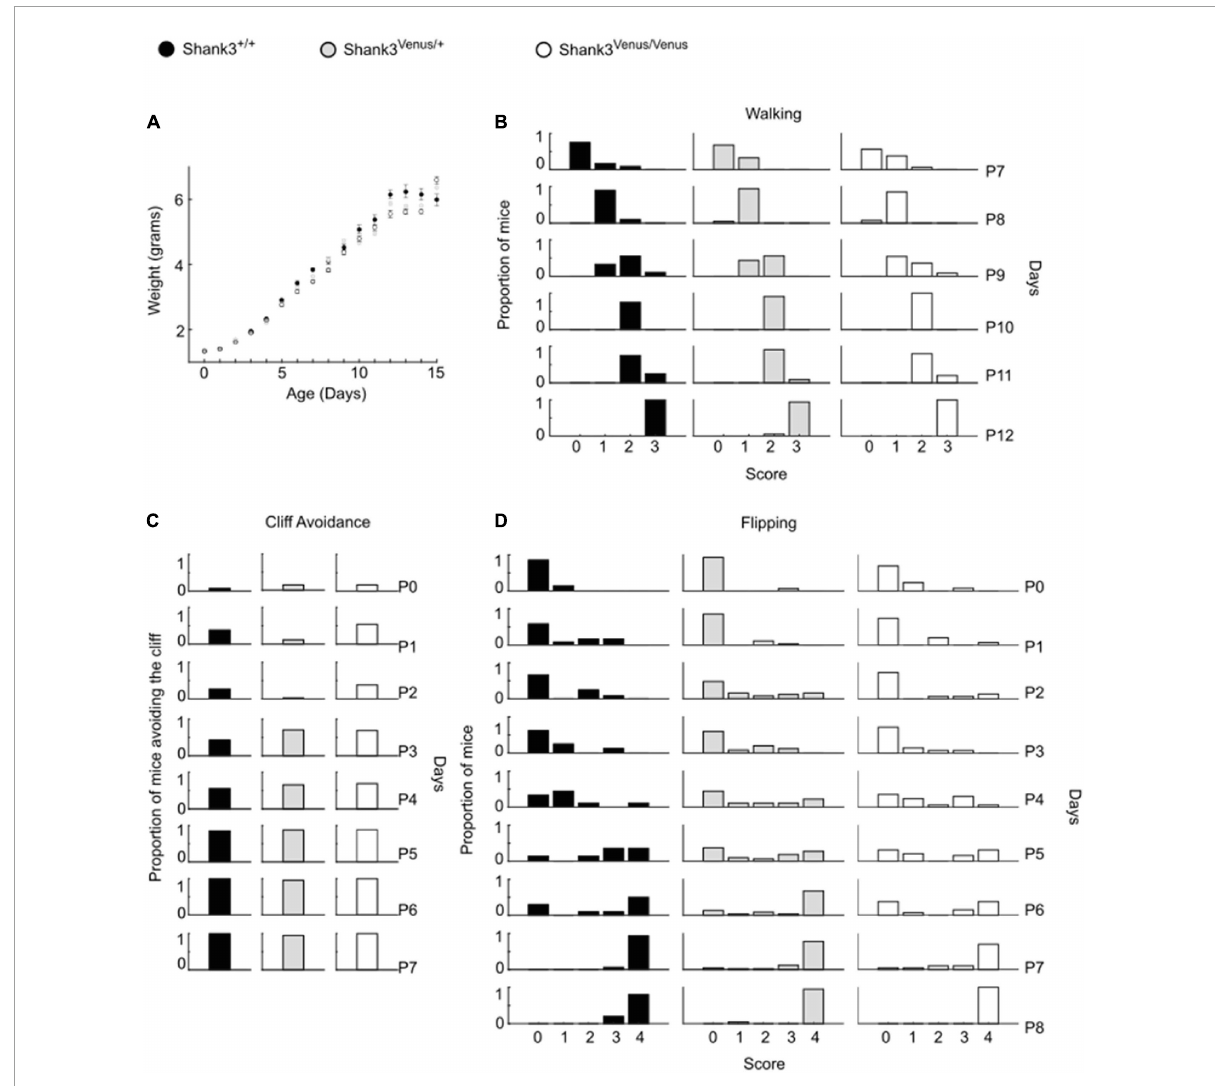
FIGURE2 Psychomotor ability test battery in Shank3 Venus / Venus , Shank3 Venus / + and Shank3 + / + KI pups. All behavioral experiments were performed on at least 18 mice per group. (A) Weight. Pups were weighed from birth to P15. Data are mean ± SEM. (B) Walking. Mice were scored for walking from P7 to P12. Data are proportion of mice reaching the different score through days. GLM, genotype effect: p -value = 0.81, interaction genotype by time: p -value = 0.48. (C) Cliff Avoidance. Proportion of mice avoiding the cliff from birth to P7. GLM, p -value = 1.00. (D) Flipping . Mice were scored in their ability to flip over when put on their back from birth to P8. Data are proportion of mice reaching the different score through days. GLM, p -value =